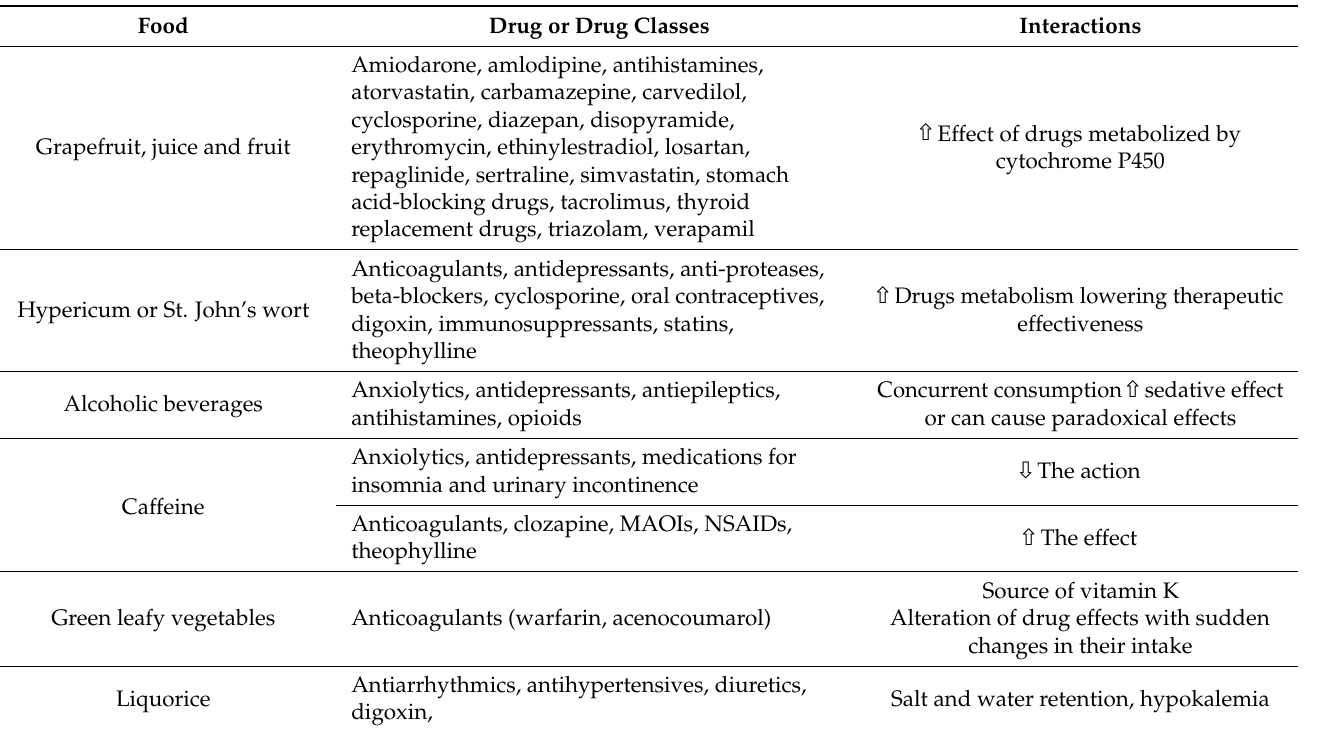
Table 3. Food–drug interactions. Foods to avoid or not to take in conjunctions with medications, due to the risk of severe interference with drugs.